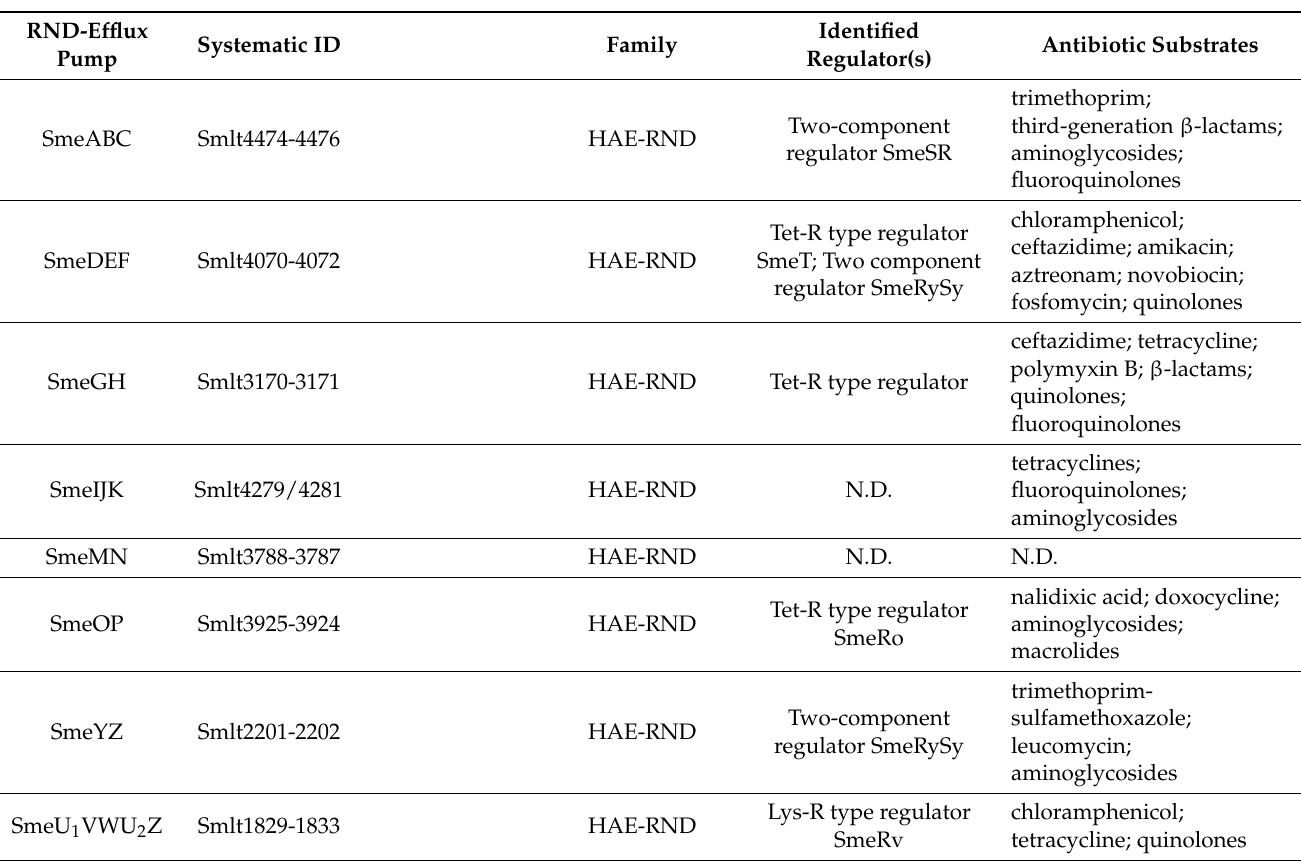
Table 4. RND efflux pumps in S. maltophilia